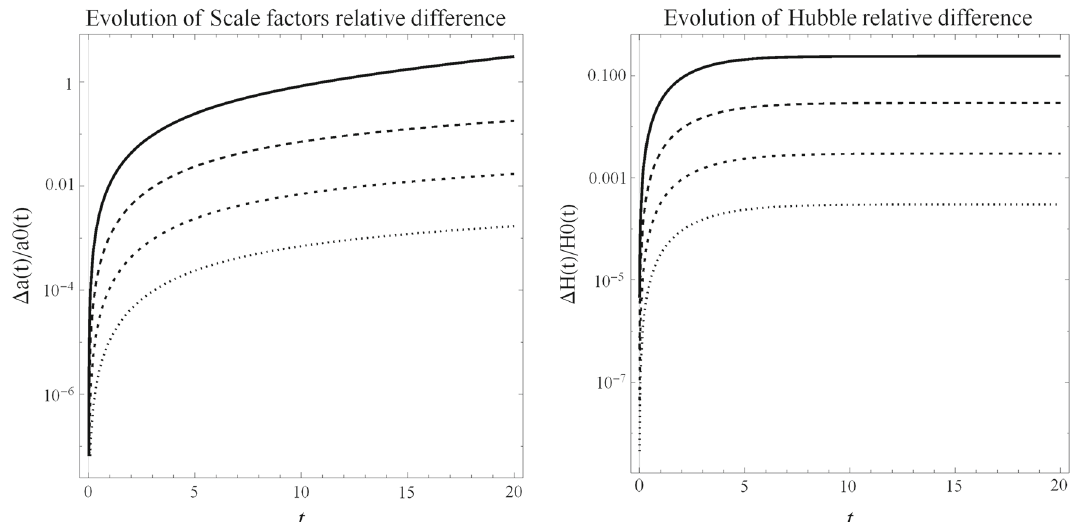
Fig. 4 Qualitative evolution in time for the relative difference between the solutions of the master equation (12) for λ 0 = 0, with λ 0 (cid:5)= 0 and n = − 1. Left figure is for the scale factors while right figure for the Hubble functions. For the numerical integration we considered λ = 1, while the solid line provides the relative error of solution 2